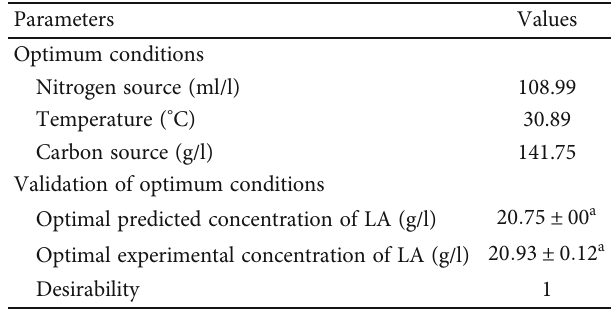
Table 8: Predicted and experimental lactic acid production using optimal culture